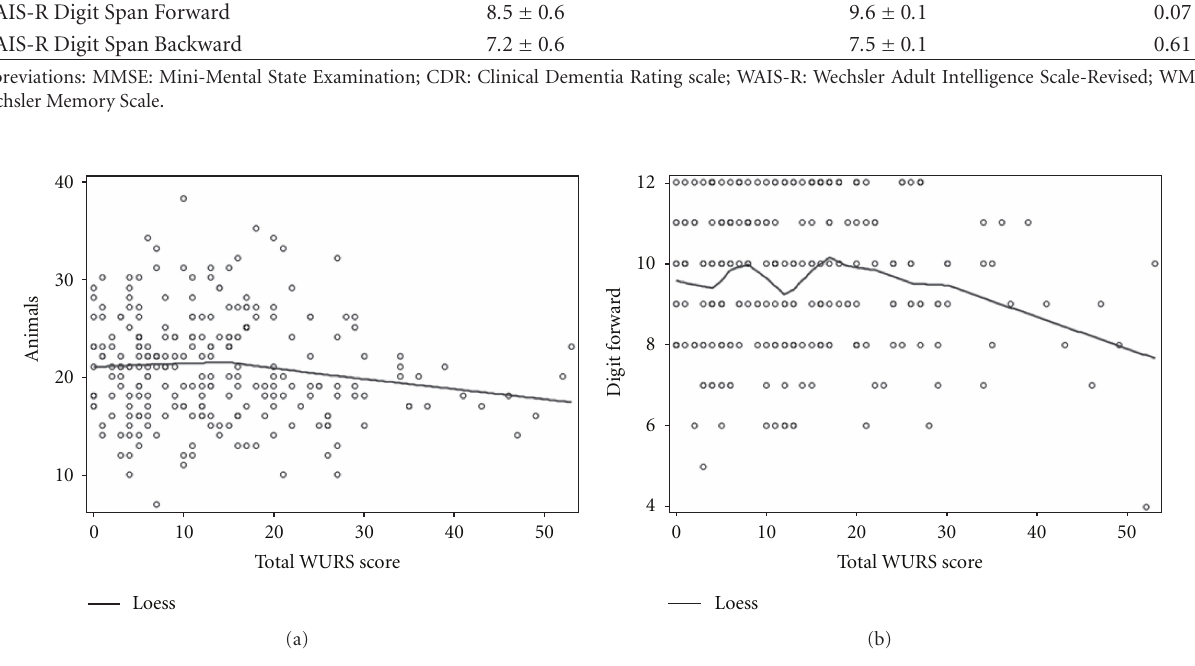
Figure 1: Scatterplots of (a) animal naming total words ( P = 0 . 030) and (b) WAIS digit span total length ( P = 0 . 037) versus WURS scores with LOESS fit using WURS scores squared as a quadratic term after adjustment for age and education. Data presented is for cognitively normal subjects